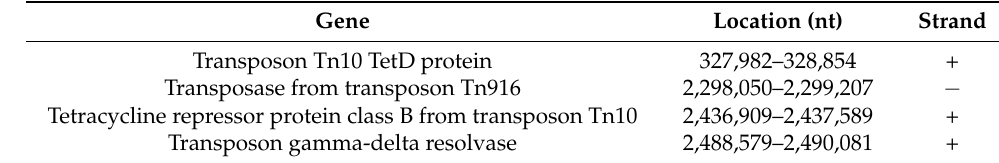
Table 7. Transposases and transposons predicted in the B . subtilis IDCC1101